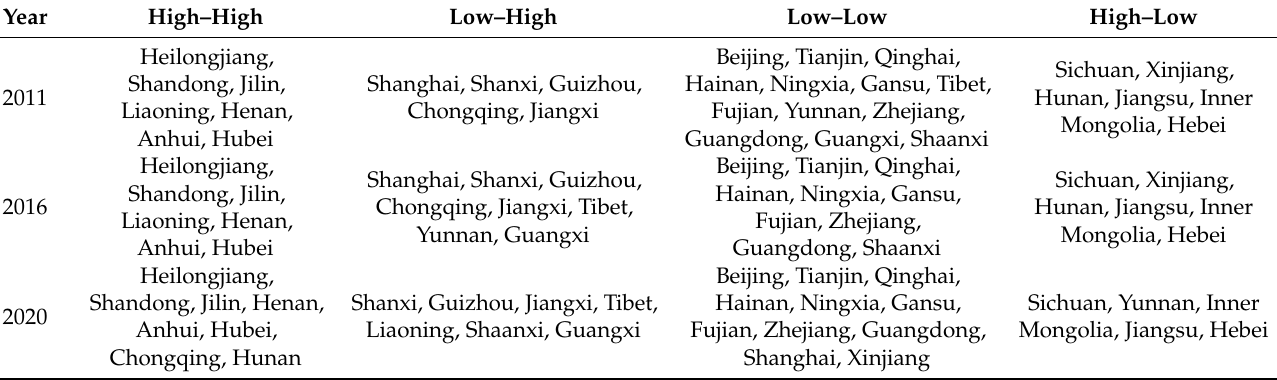
Table 10. Local spatial clustering of coupling coordination levels in 31 provinces in main